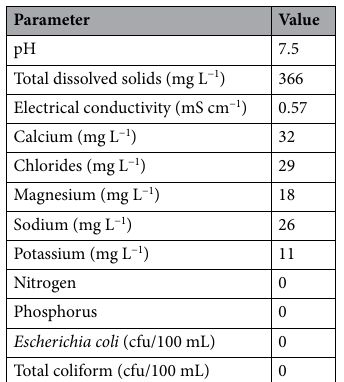
Table 4. The physicochemical parameters of water prior to the addition of crude oil. cfu Colony forming